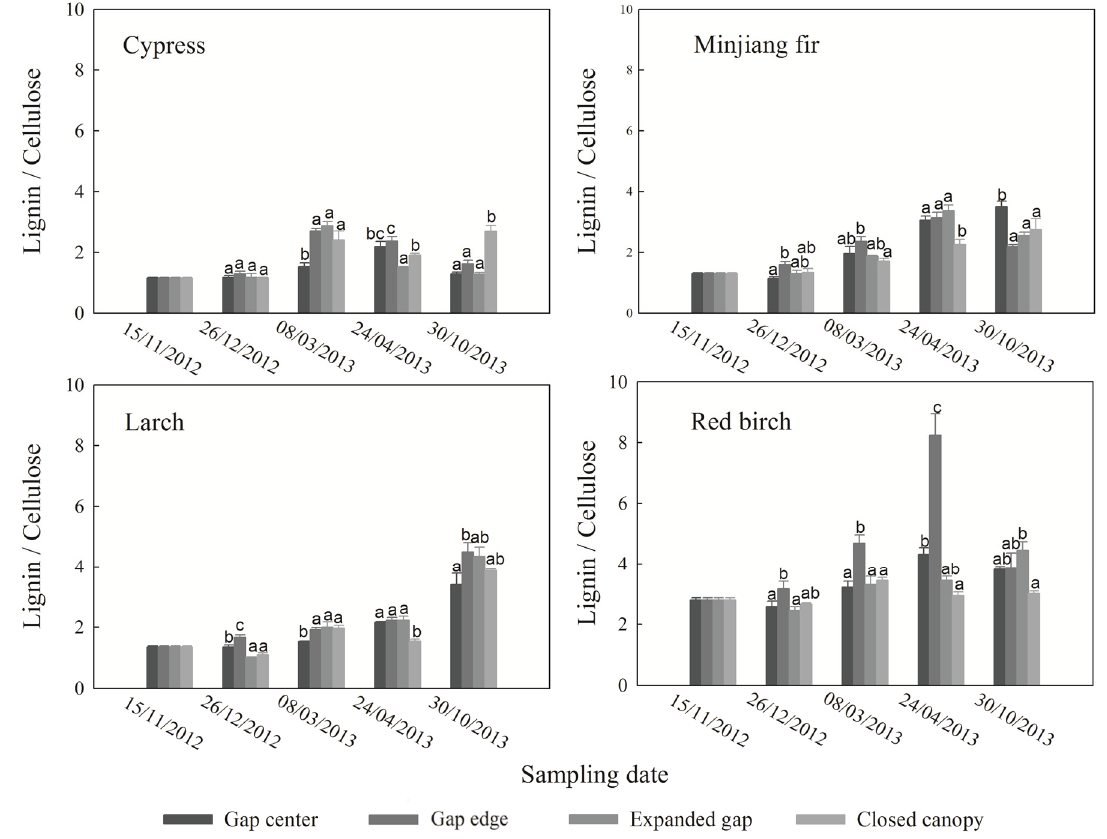
Figure 7. The lignin/cellulose concentration ratio in the four types of foliar litter (cypress, fir, larch, red birch) in the four gap positions (gap center, gap edge, expanded gap, closed canopy) at each sampling date over the first year of litter decomposition in an alpine Minjiang fir forest. Different lowercase letters indicate significant differences among gap positions within the same sampling time, p < 0.05 (mean ± SE, n = 3).